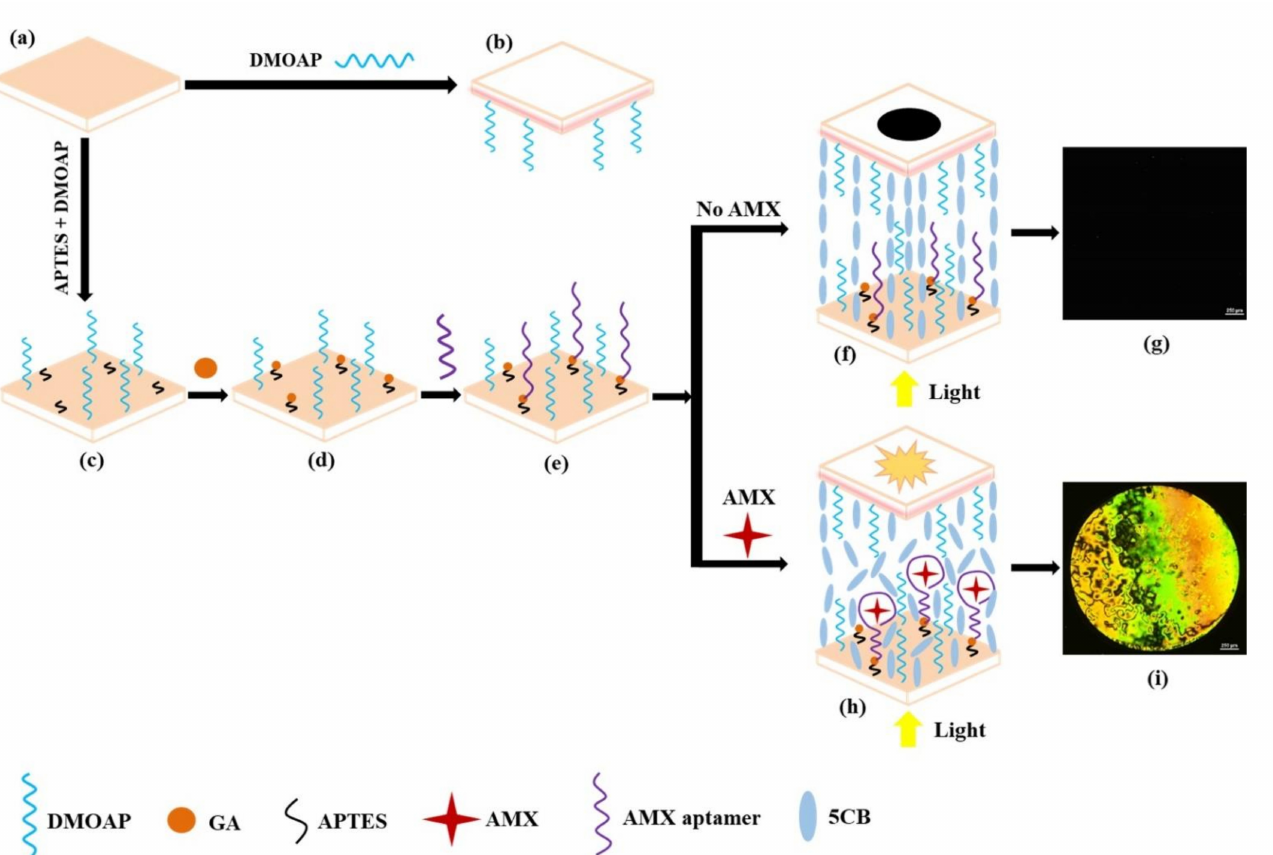
Figure 1. Schematic illustration of the sensing strategy for detecting amoxicillin (AMX) ( a ) Cleaned glass slide; ( b ) upper glass slide; ( c ) the self-assembled monolayer of (3-aminopropyl) triethoxysilane (APTES)/dimethyloctadecyl [3- (trimethoxysilyl) propyl] ammonium chloride (DMOAP) on the glass substrate; ( d ) grafting of glutaraldehyde (GA) onto APTES/DMOAP-modified glass substrate; ( e ) immobilization of the AMX aptamer onto (APTES + GA)/DMOAP-modified glass substrate; ( f ) homeotropic orientation of liquid crystals (LCs) in the absence of AMX; ( g ) polarized optical image of an LC cell in the absence of AMX; ( h ) the conformational change in AMX aptamer after binding to AMX disrupts the homeotropic orientation of LCs; and ( i ) polarized optical image of an LC cell in the presence of AMX. The bright circular spot is caused by the specific binding of aptamer and